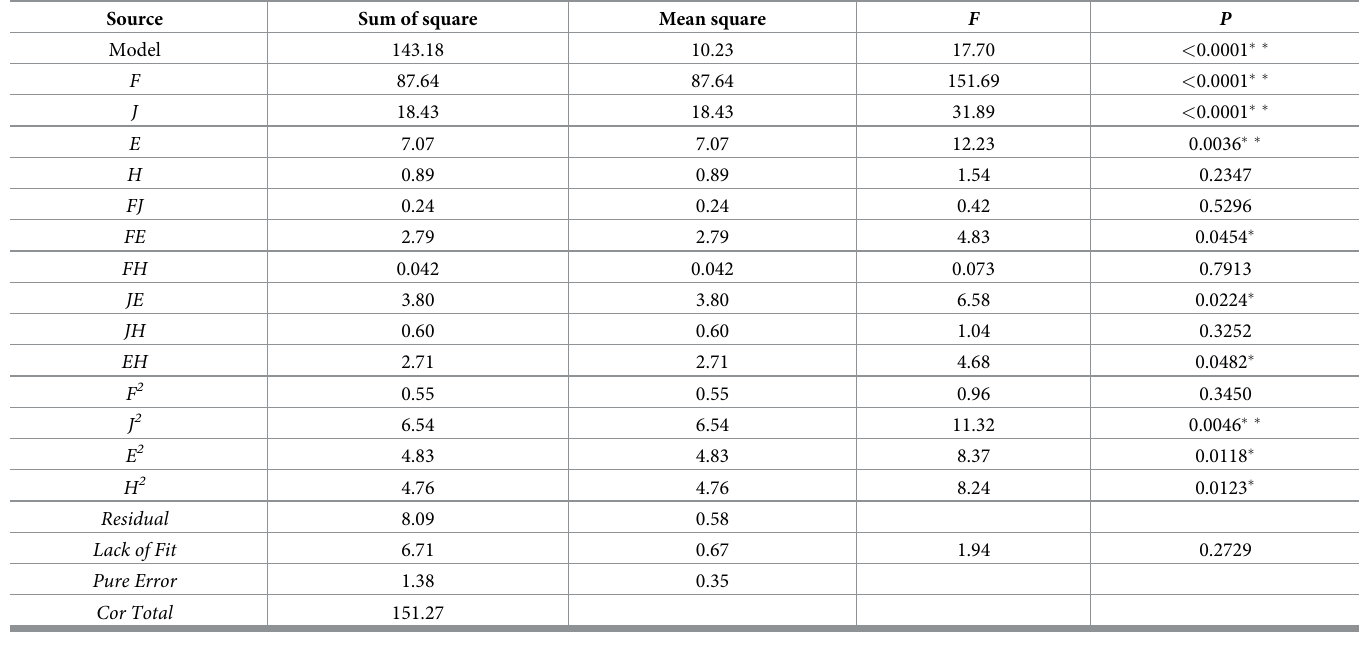
Table 7. Variation analysis of Box-Behnken test quadratic model.